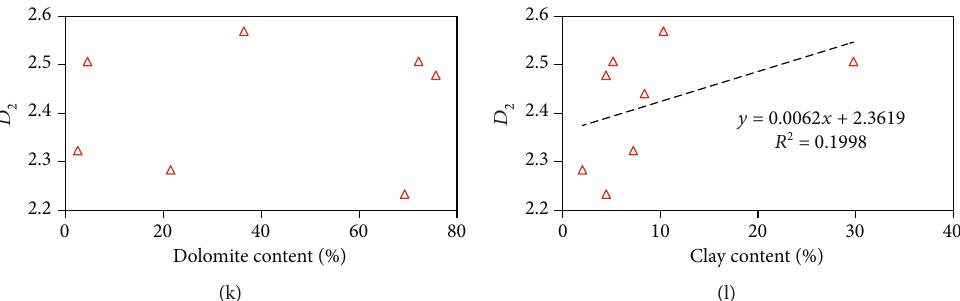
Figure 10: Crossplots of N adsorption parameters and mineral compositions of the Palaeogene Xiaganchaigou Formation samples from 2 Qaidam Basin.